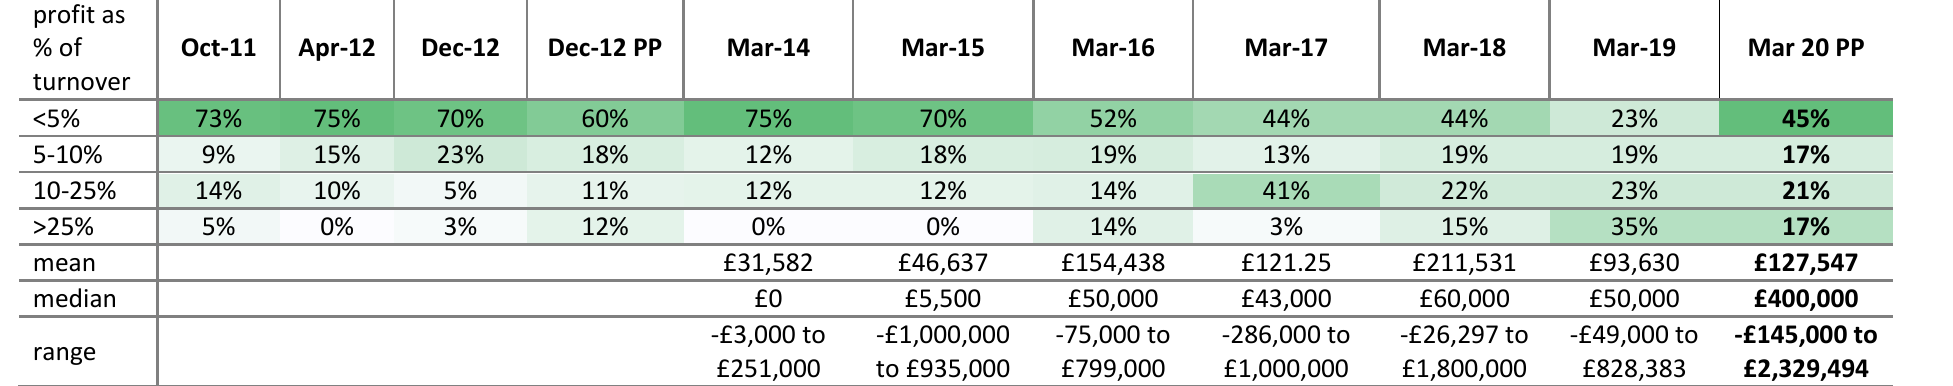
Table 13: Distribution of profits, mean, median and ranges of reported profits from 2011 to 2020. PP = Profiling the profession , data comes from Profiling the Profession